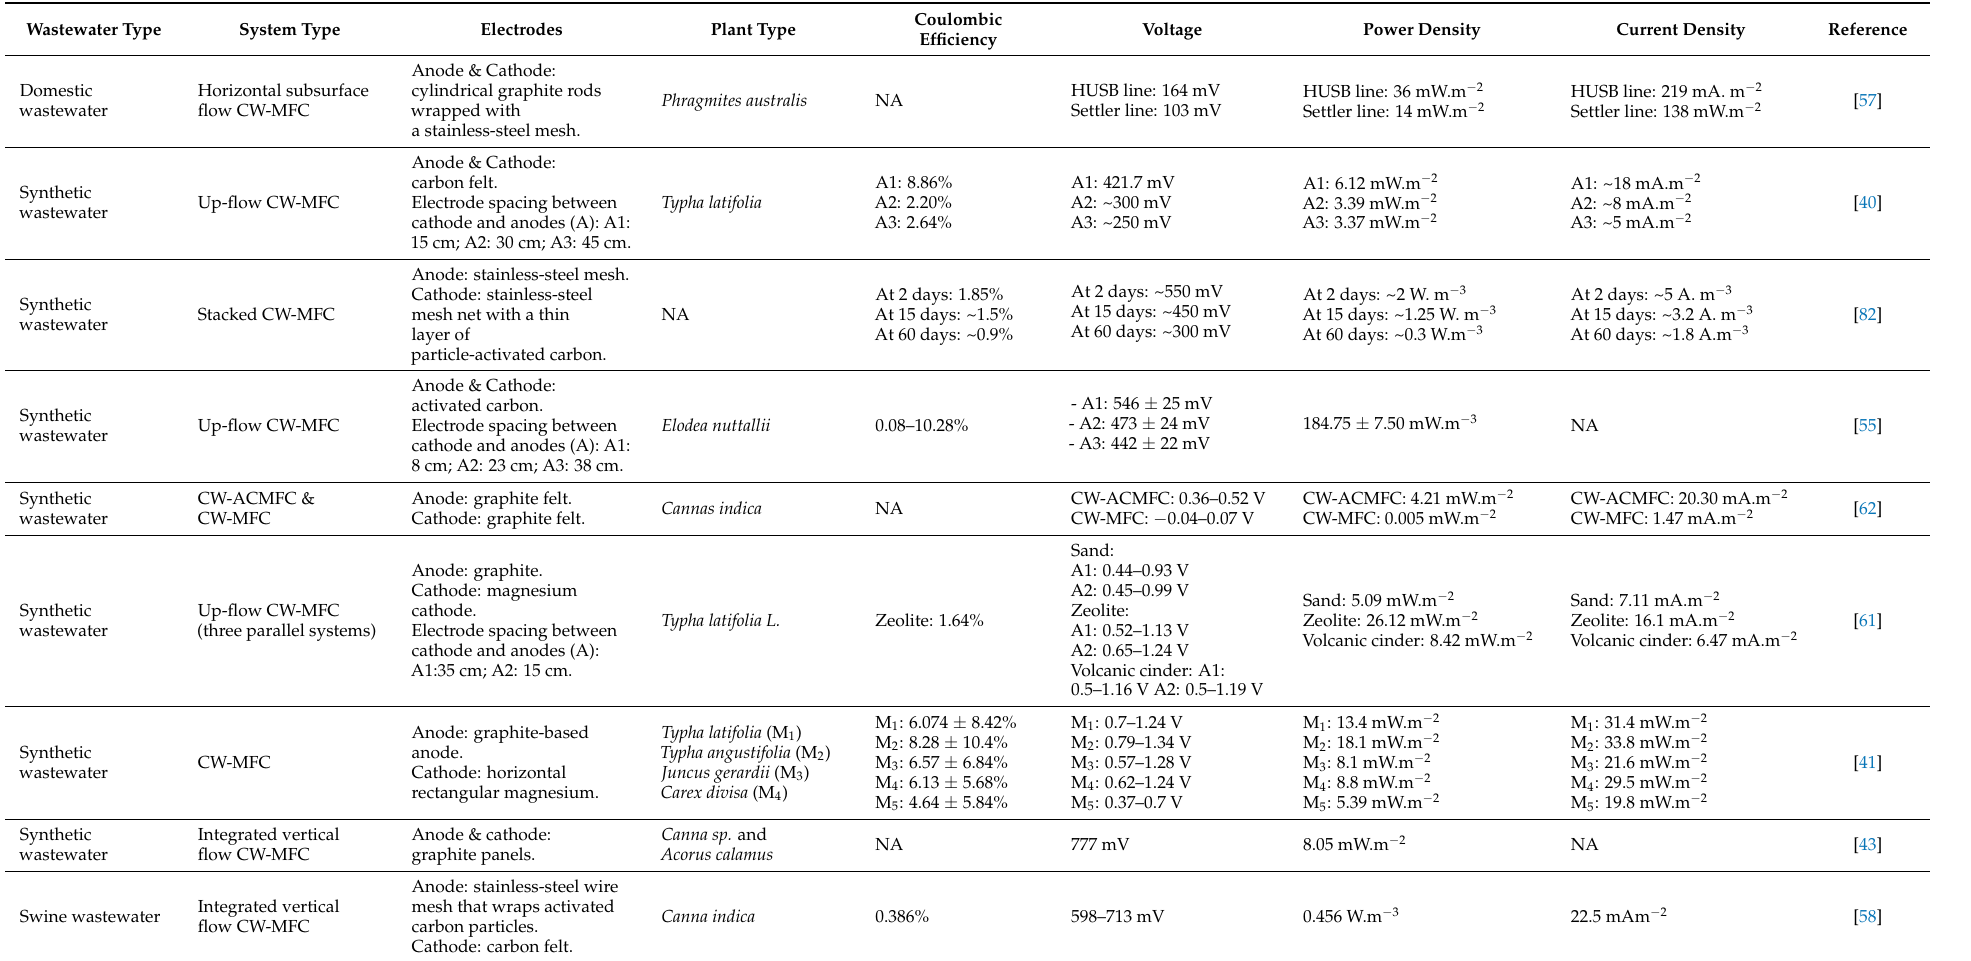
Table 1. Energy recovery in Hyp-MFC and CW-MFC